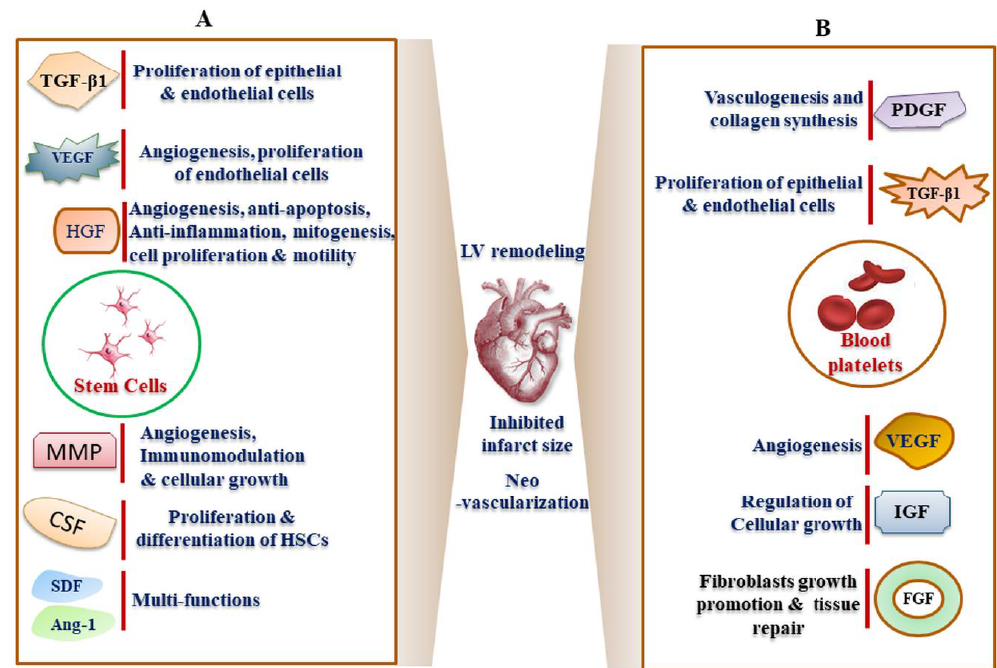
Figure 4. Cargo of growth factors releasate from ( A ) stem cells and ( B ) blood platelets which play a possible role in inhibiting myocardial infarct. The specific growth factors include angiopoietin (Ang-1), colony stimulating factor (CSF), fibroblast growth factors (FGF), insulin-like growth factors (IGF), hepatocyte growth factor (HGF), intercellular adhesion molecule (ICAM), matrix metalloprotease (MMP), platelet-derived growth factor (PDGF), stromal cell-derived factor 1 (SDF-1), transforming growth factor beta 1 (TGF- β 1), vascular endothelial growth factor (VEGF), transforming growth factor (TGF) etc.